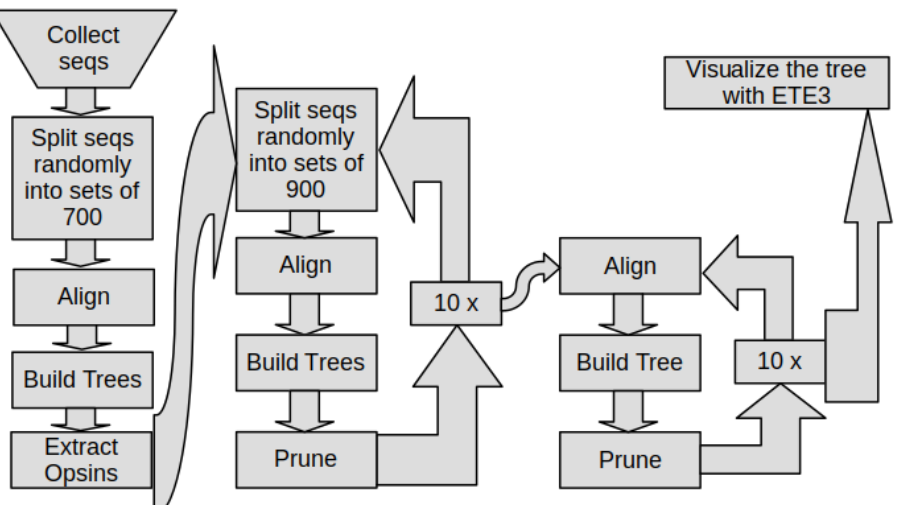
Figure 1. Flowchart of the pipeline used for reconstructing our opsin phylogeny. The pipeline starts with the bait sequences and uses them to collect similar sequences with BLAST from public sequences databases. The sequences are filtered for opsins by building phylogenetic trees and extracting the opsin clade from them. It adds back outgroup sequences (not shown in the chart). With this set, it then reconstructs small trees ten times for fast rogue pruning, followed by trees with the full sequence set for rogue pruning ten times, since what a rogue is, is determined by all other sequences in the set. After rogue pruning, the final tree is visualized with ETE3. The last step is manual and can be applied to all trees.